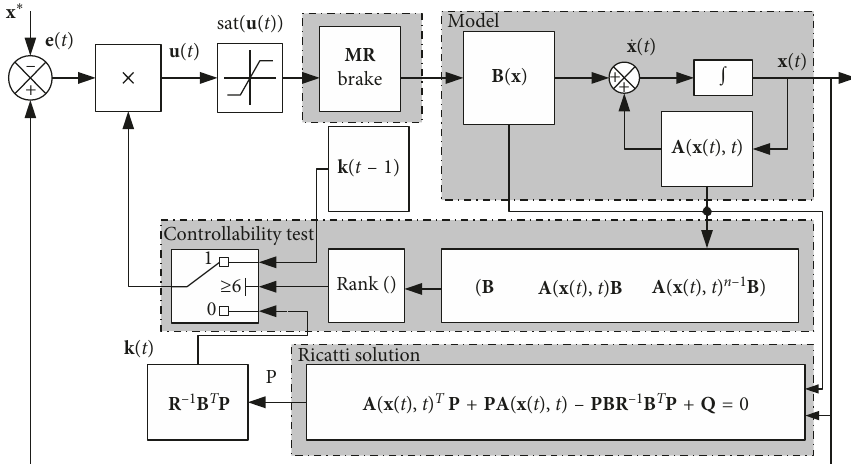
Figure 12: Block diagram of the system with control applied to the DC motor and MR brake.